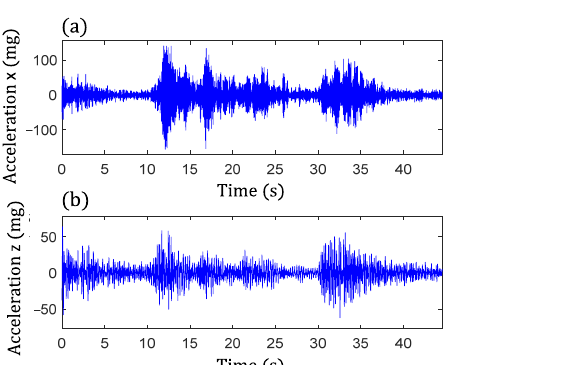
Figure 14. Acceleration measurements containing single impulsive traffic event: ( a ) lateral direction and ( b ) vertical direction. Figure 15. Single impulse traffic event: ( a ) raw data and ( b ) magnitude, |𝑊(𝑡,𝑠)| (cid:3007) , of cross-frame Figure 15. Single impulse traffic event: ( a ) raw data and ( b ) magnitude, | W ( t , s ) | strain, 𝐹(𝑡) , and ( c ) raw data and ( d ) magnitude, |𝑊(𝑡,𝑠)| (cid:3004) , of large-area strain, ∆𝐶(𝑡) . strain, F ( t ) , and ( c ) raw data and ( d ) magnitude, | W ( t , s ) |